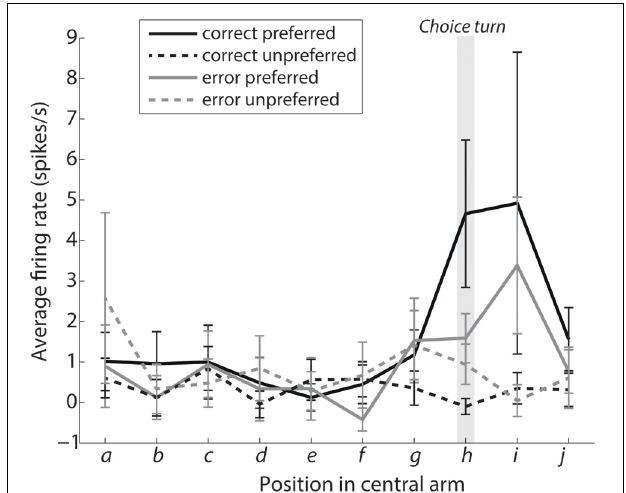
FIGURE 4 | Turn selective mPFC neurons display prospective ramping of activity before a choice turn in their preferred turn direction. The curves show the average firing rates during intervals leading to the choice turn labeled as shown in Figure 1E . Interval h encompasses the choice turn per se , with intervals i and j directly following the choice turn. Solid lines show the average activity of turn-selective neurons from trials when the rat turned in direction preferred by the neuron, while dashed lines are based on trials when the rat turned in the opposite direction. Please note that selectivity for the preferred direction during the choice turn is significantly reduced during error trials (shown in gray, P < 0 .